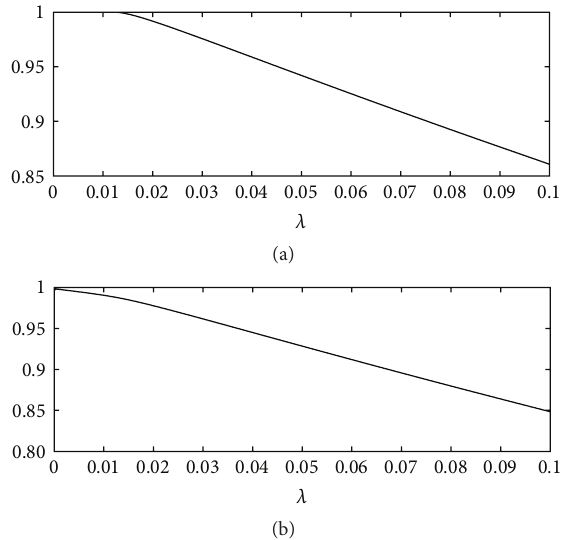
Figure 8: Loan value as a function of the intensity. (a) Regime 𝑋 = 𝑒 𝑋 = 𝑒 1 ; (b) regime 2 . The loan value is decreasing when there is a degradation of the credit quality (i.e., when 𝜆 increases) and converges to 0.